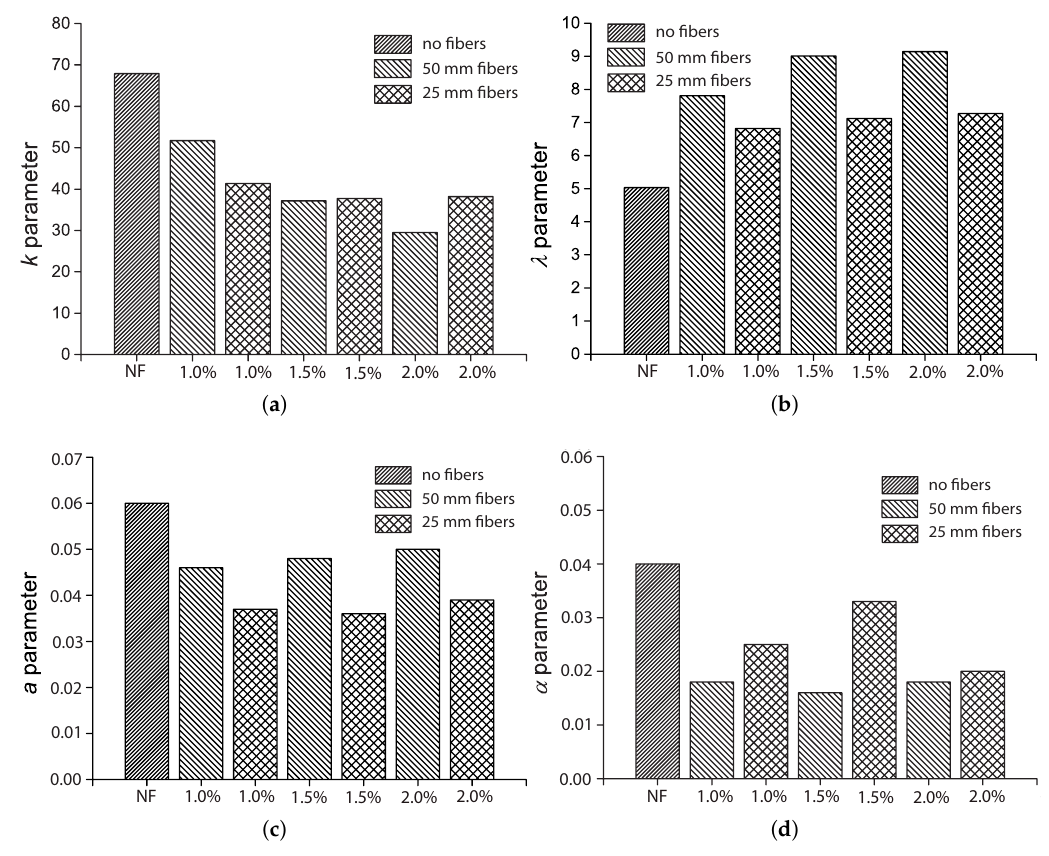
Figure 15. Influence of fiber length on model parameters: ( a ) k ; ( b ) λ , ( c ) a and ( d ) α , by fitting the flexural fatigue tests by Mohammadi and Kaushik